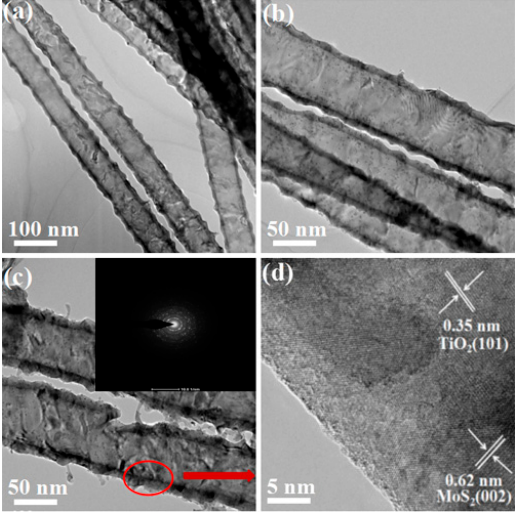
Figure 3. TEM images of ( a ) TiO 2 NTs; ( b ) TiO 2 NTs/Ag; and ( c ) TiO 2 NTs/Ag/MoS 2 (inset: SAED pattern); ( d ) HRTEM image of TiO 2 NTs/Ag/MoS 2 .